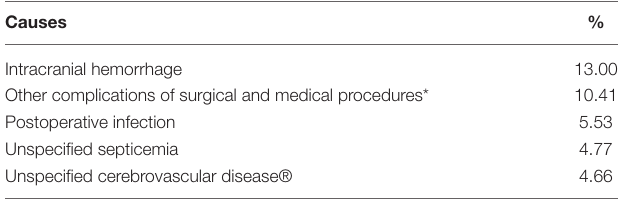
TABLE 4A | Top causes of readmission in open surgical population (Weighted N = 296). Causes